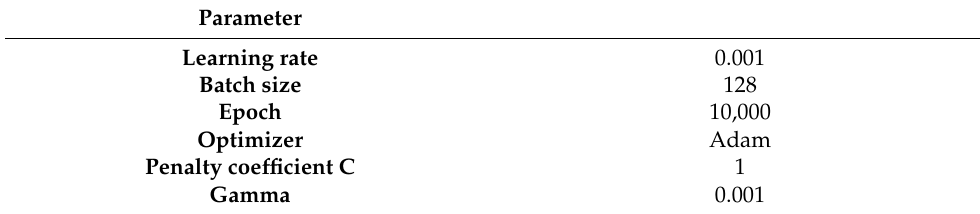
Table 4. Setting parameters of training SVM classifier.